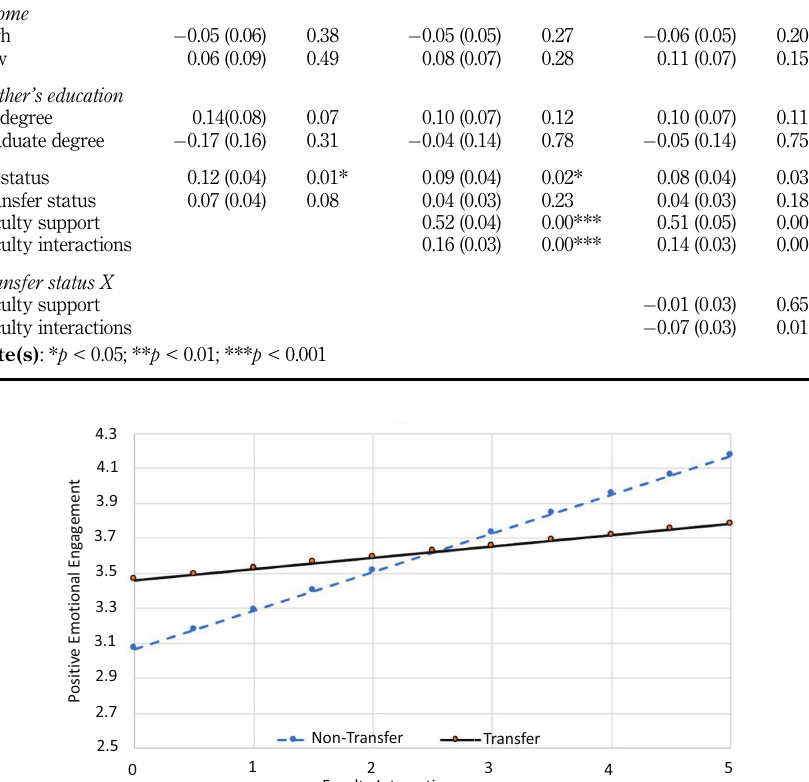
Figure 3. Interactions between transfer status and faculty